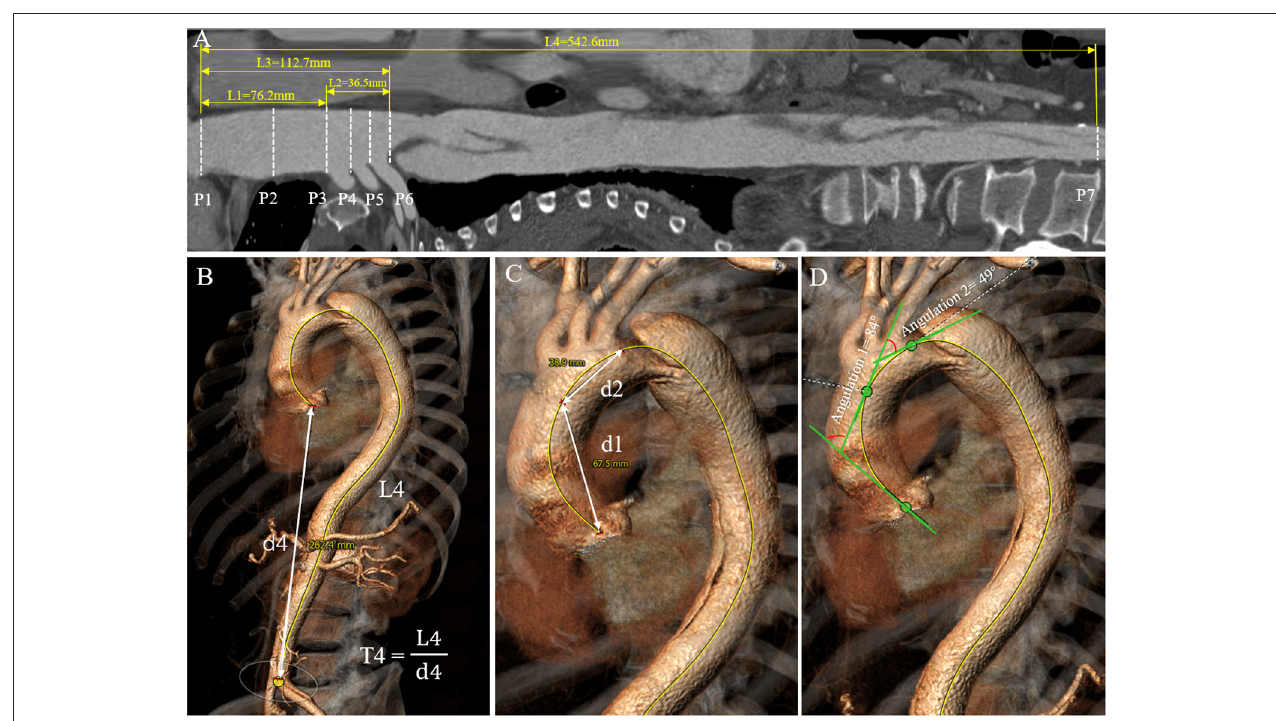
FIGURE 1 | Aortic diameter, length, tortuosity, and angulation measurement process. (A) The length measurement of each aortic segment (L1–L4) on the stretched view and aortic diameter measurement at the landmarks D1–D6. (B,C) Tortuosities of the total aorta, ascending aorta and aortic arch were measured by dividing the length of the centerline (L) by the linear distance (d) between the first and last points in each aortic segment. (D) Angulations of the ascending aorta and aortic arch were measured as the angle formed by the tangent lines drawn along the first and last points of the aortic centerline in each aortic